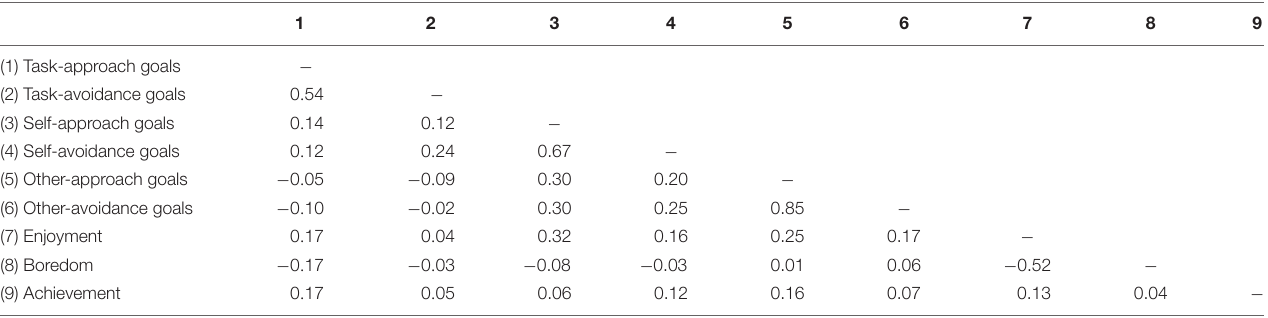
TABLE 2 | Intercorrelations among the achievement goal variables, emotions, and